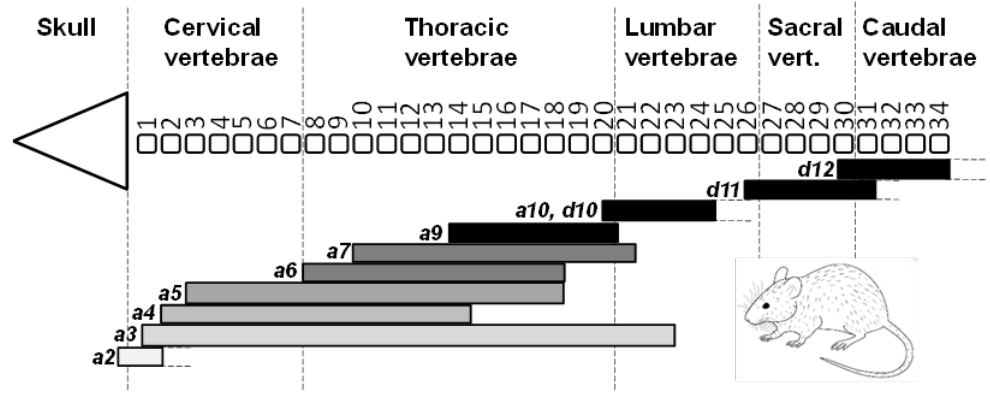
Figure 7. Mouse Hoxa and/or Hoxd expression domains within the pre-vertebral column of mid- gestation embryos. Hox shading intensities indicate orthologue groups, as in Figure 1. Expression patterns are as described in the following references: Hoxa4-a10 [55]; Hoxa2 [56]; Hoxa3 [57]; Hoxa10 [58]; Hoxd10-d12 [14].